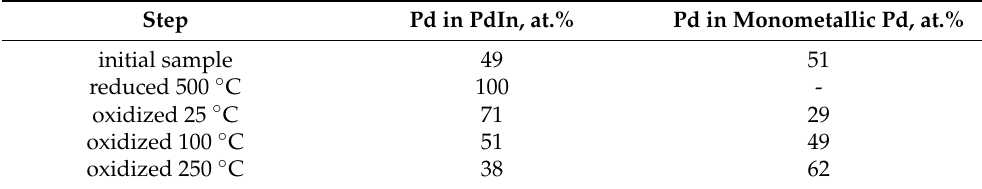
Table 3. Estimates of Pd fractions in the forms of PdIn and in monometallic palladium from FTIR data (according to the deconvolution of peaks of linearly adsorbed CO). Step Pd in PdIn, at.% Pd in Monometallic Pd, at.% initial sample 49 51 reduced 500 ◦